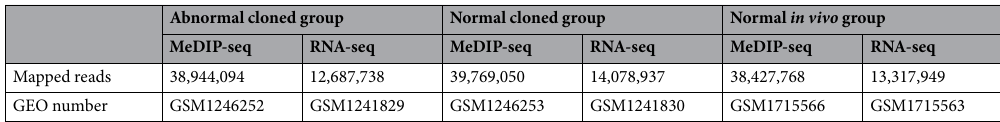
Table 1. Mapped resds number and sample source of MeDIP-seq RNA-seq data. MeDIP-seq: methylated DNA immunoprecipitation